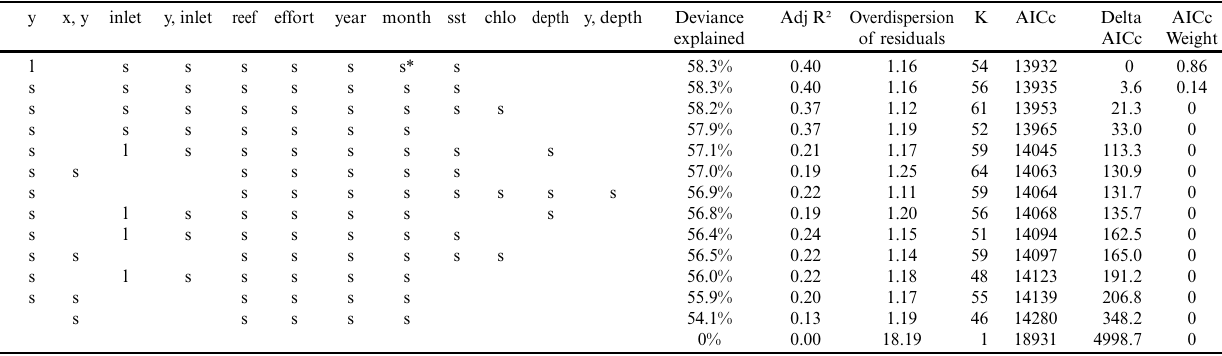
Table 2. Model selection of recreational vessel relative abundance. Covariates included: x = easting, y = northing, x:y = interaction term between easting and northing, inlet = distance to the nearest inlet, y:inlet = interaction term between northing and inlet, reef = reef abundance per sampling unit, depth = bathymetry, y:depth = interaction term between latitude and depth, effort = km², survey year = winter of survey, month = data collection month, sst = sea surface temperature, chlo = chlorophyll a concentrations, and K = number of